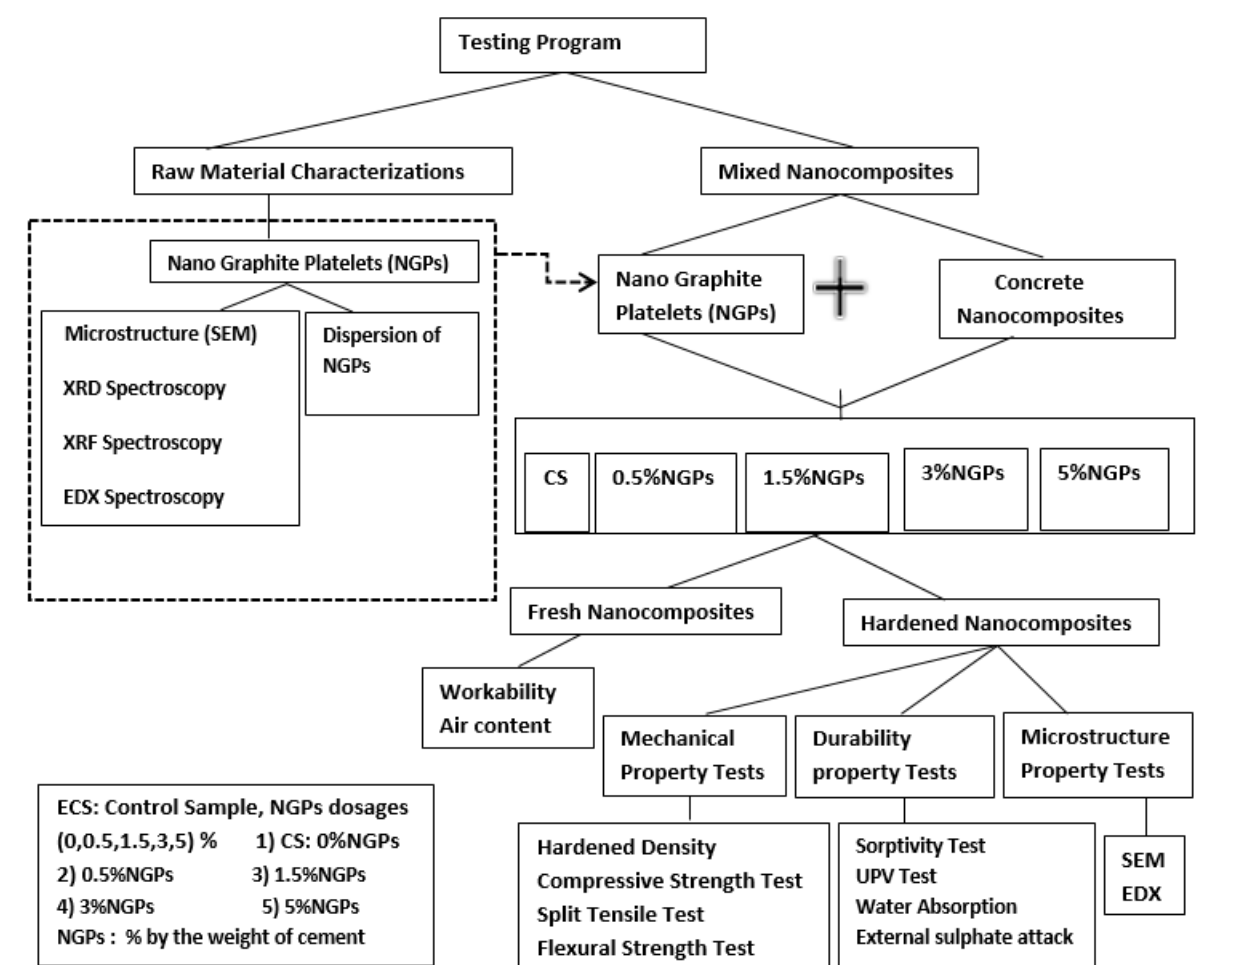
Figure 2. Experimental program flow chart. Reproduced with permission from Ref. [5]. Copyright (2021), Elsevier Ltd.